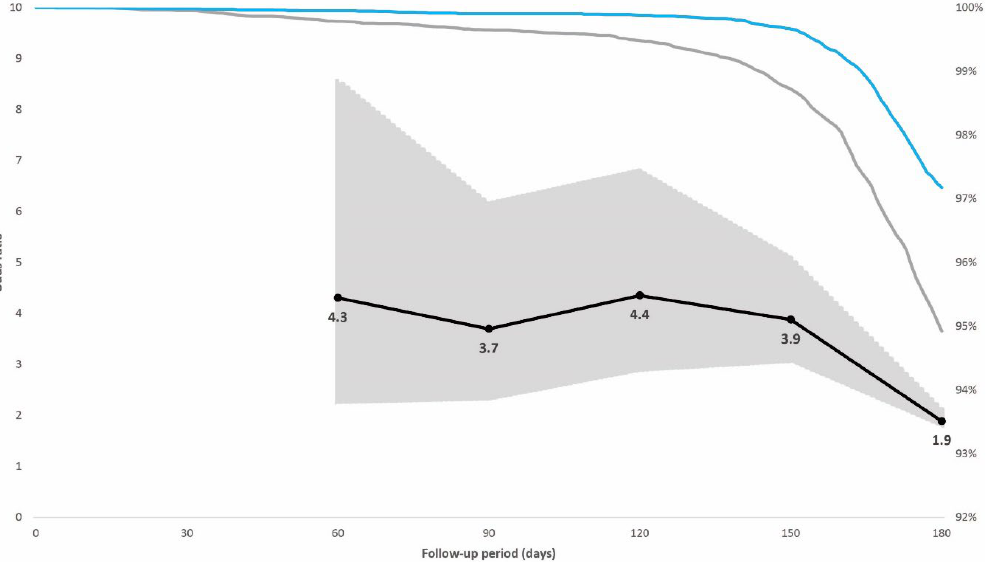
Figure 3. Individuals in the case-control population vaccinated in the non-prioritized second phase. Right vertical axis: distribution of breakthrough infections in the 180-day follow-up period dis- played by immunity status at baseline (blue line hybrid immunity, grey line vaccination only). Left vertical axis: odds ratios (black line) including 95% confidence intervals (grey-shaded area) for breakthrough infections adjusted for booster dose administration among individuals with vaccina- tion alone compared with individuals with hybrid immunity for post-vaccination days 60, 90, 120, 150, and 180. The Omicron variant replaced Delta as the dominant variant in the weeks before and after day 120 of the follow-up period. 3.4. Booster Doses of Vaccine In the prioritized population, receiving a booster dose of vaccine during the follow- up period was highly protective against breakthrough infection. The odds ratio for break- through infection adjusted for hybrid immunity, age, sex, and vaccination week for indi- viduals who had not received a booster dose was 27 (95% CI, 11–66; p < 0.001) compared with those who had received a booster dose. Individuals with hybrid immunity who had not received a booster dose had an unadjusted odds ratio of 17 (simplified analysis due to few events) for breakthrough infection, compared with those who had received a booster dose. Those with vaccination alone who had not received a booster dose had an unad- justed odds ratio of 38 (simplified analysis due to few events) for breakthrough infection. In addition, in the non-prioritized population, receiving a booster dose of vaccine was inversely associated with breakthrough infection. Individuals who had not received a booster dose had an adjusted odds ratio of 8.4 (95% CI, 7.3–9.8; p < 0.001) for breakthrough infection. The individuals with hybrid immunity who had not received a booster dose had an adjusted odds ratio of 9.4 (95% CI, 7.7–12; p < 0.001) for breakthrough infection, com- pared with those who had received a booster dose; the corresponding odds ratio for indi- viduals with vaccination alone was 7.1 (95% CI, 5.7–9.0; p < 0.001). 4. Discussion This study set out to compare the effectiveness of the BNT162b2 mRNA vaccine to hybrid immunity in a naturalistic setting in Sweden between January 2021 and February 2022. In a first vaccinated prioritized population exposed to the initial SARS-CoV-2 vari- ants post-vaccination, we found 2 months after vaccination that the vaccinated-only con- trols did not show an increased likelihood for breakthrough infection compared with cases of hybrid immunity but that, at the end of the 6-month follow-up period, the